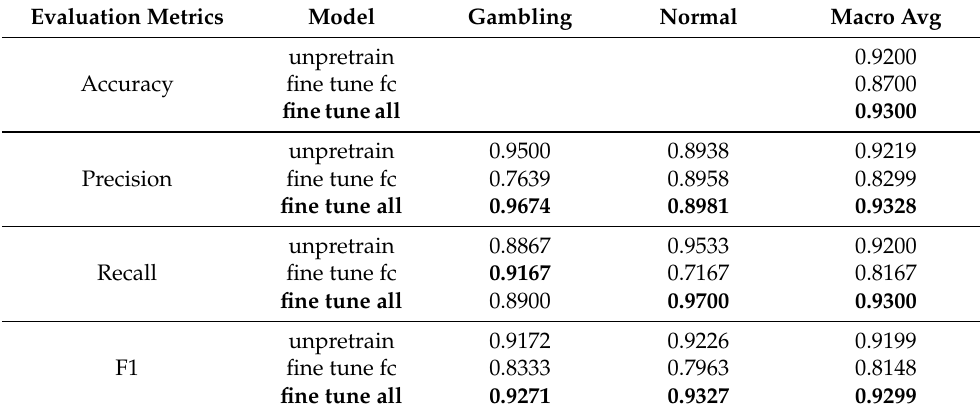
Table 3. Results of different fine tuning